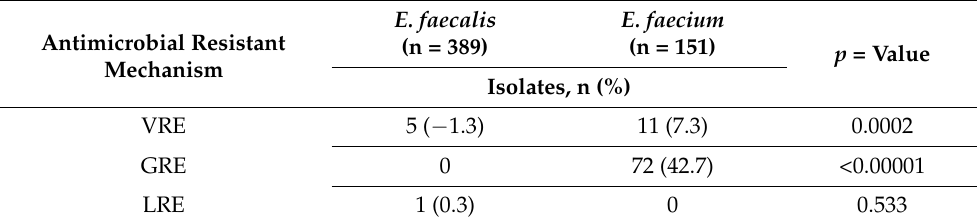
Table 4. Occurrence of resistance mechanism (VRE, GRE and LRE) in enterococcal strains isolated from the urine of patients hospitalized in Nephrology and Urology Clinics between